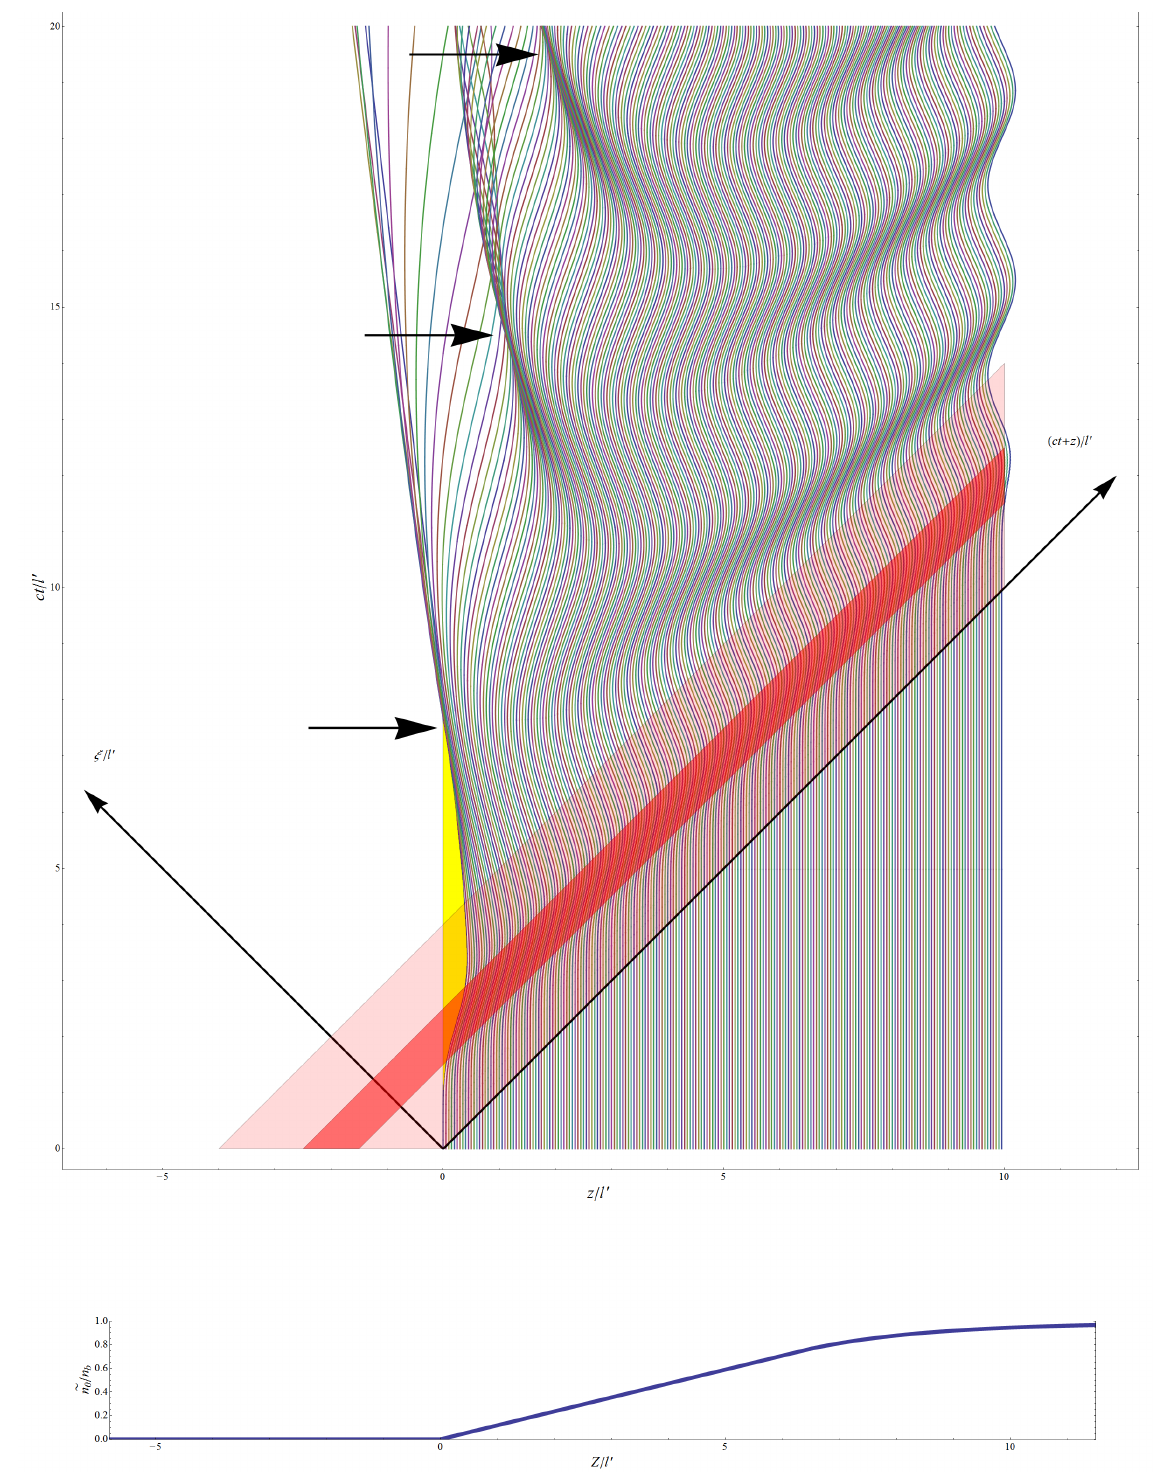
Figure 7. Down : the initial electron density (3) of Figure 2. Up : The worldlines of Z -electrons interacting with the pulse in Figure 1 for 200 equidistant values of Z ; the support 0 ≤ ct − z ≤ l and the ’effective support’ ( l − l (cid:48) ) /2 ≤ ct − z ≤ ( l + l (cid:48) ) /2 of the pulse are pink and red;, respectively, while the spacetime region of the pure-ion layer is yellow. Horizontal arrows pinpoint where particular subsets of worldlines first